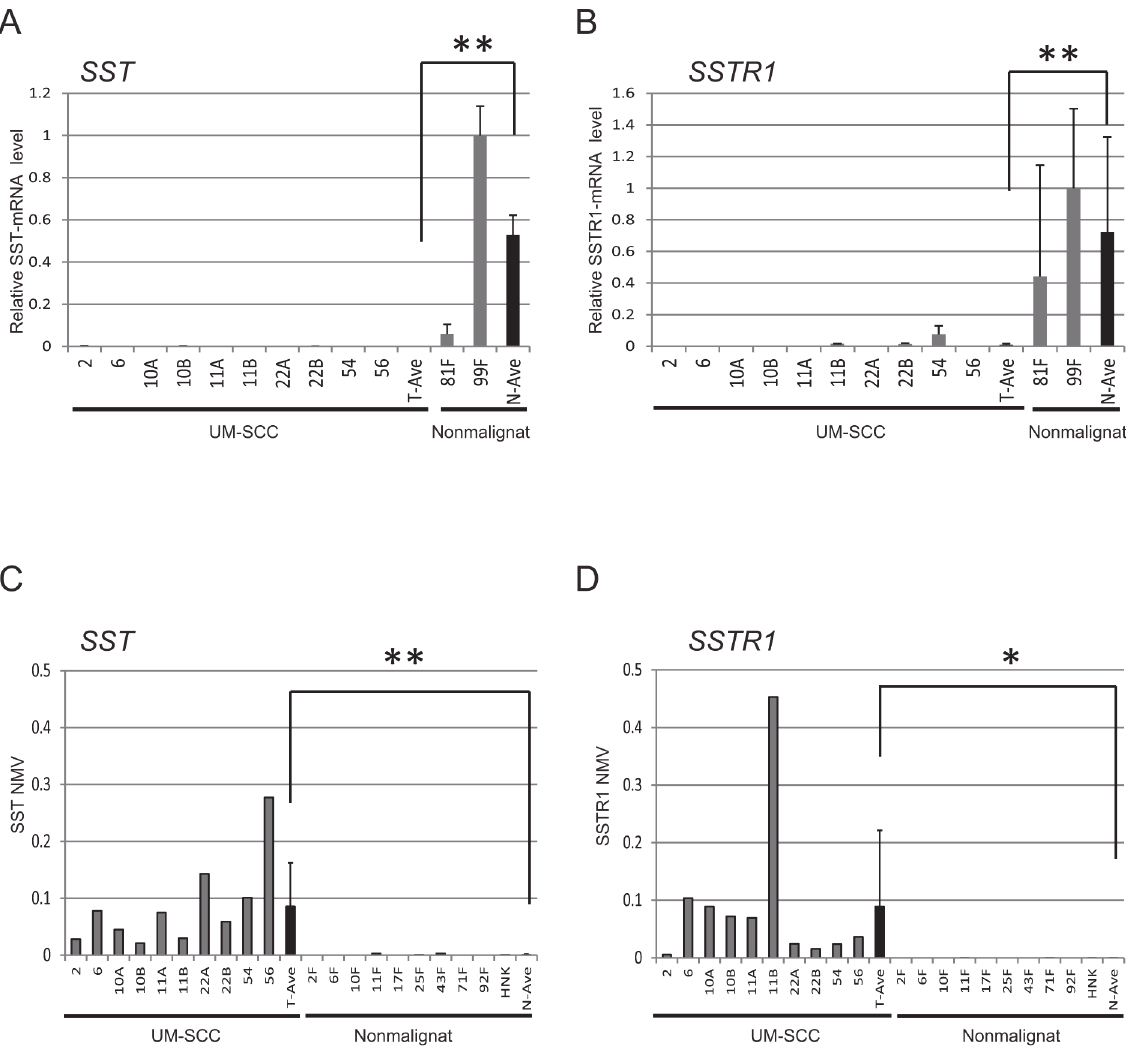
Fig 1. Diagrammatic representation of SST methylation analysis by quantitative-MSP, expression analysis by quantitative-RT-PCR, and bisulfite sequencing analysis in UM-SCC cell lines. (A) Relative mRNA expression of SST revealed lower expression in cancer cell lines than in normal fibroblasts ( P < 0.01). The housekeeping gene GAPDH was run as a control for RNA integrity. (B) Relative mRNA expression of TACR1 revealed lower expression in cancer cell lines than in normal fibroblasts ( P < 0.01). (C) Mean SST NMV was significantly higher in cancer cell lines ( P < 0.001). (D) Representative examples of quantitative-MSP of TACR1 in cancer and normal fibroblasts and keratinocytes; there was a significant difference in NMV ( P < 0.05).